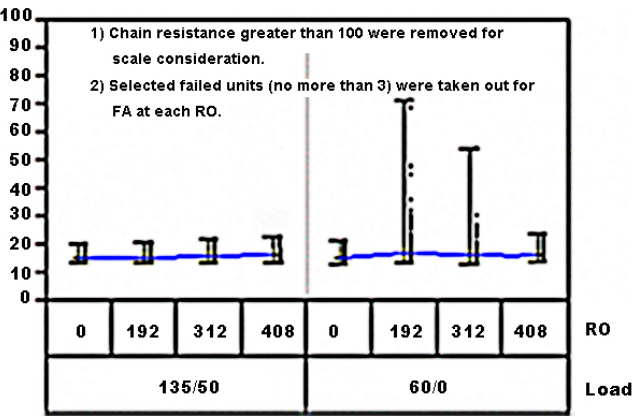
Figure 7. Variability chart for low-level contact resistance.